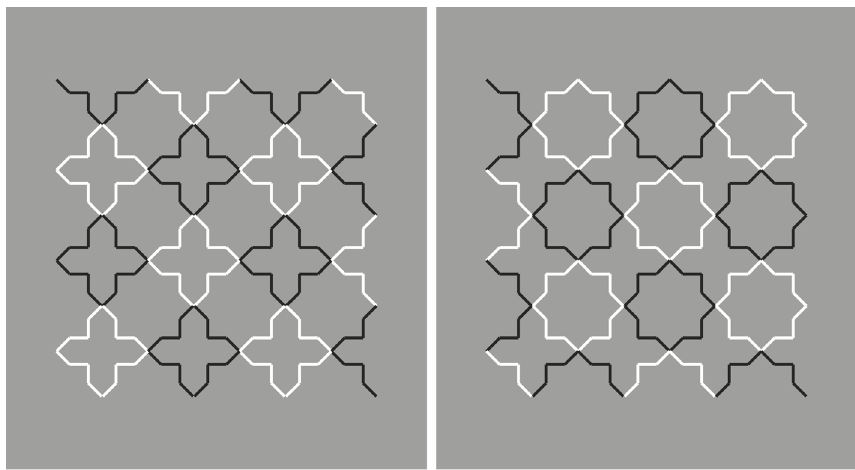
Figure 2. Crosses and stars due to the similarity principle of contrast polarity.